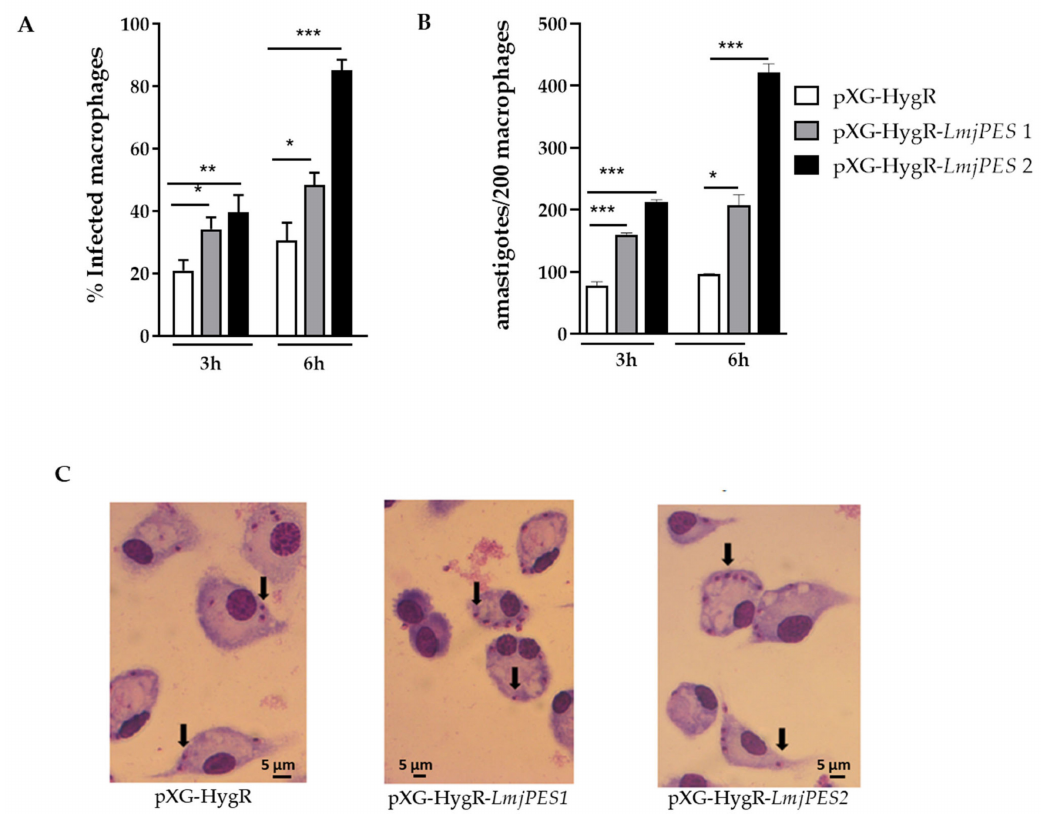
Figure 5. LmjPES overexpression increases infectivity rates in vitro . Analyses were conducted with two LmjPES - overexpressing L. major strains (pXG-HygR- LmjPES1 and pXG-HygR- LmjPES2 ). ( A ) The percentage of infected macrophages and ( B ) the number of amastigotes per 200 infected cells were evaluated by microscopy counting after Giemsa staining at 3 and 6 h post-infection. ( C ) The observed changes in the infectivity rate throughout the in vitro infection caused by overexpressing and non-overexpressing parasites were graphed for one representative experiment. Solid black arrows indicate Giemsa-stained amastigotes. Data represent the means ( ± SD) from the triplicates of at least three independent experiments (* p < 0.05, ** p < 0.01, *** p <